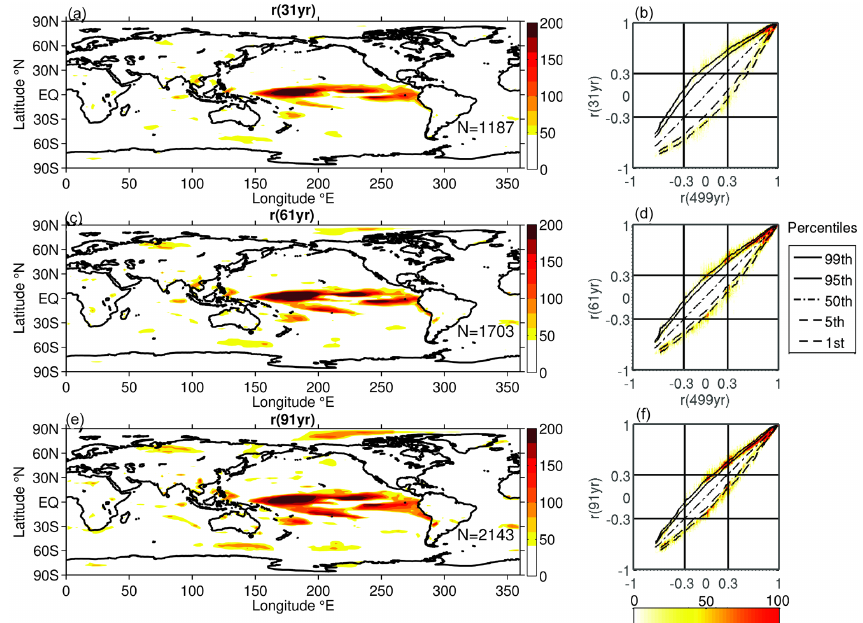
Figure 2. Panels (a) , (c) and (e) show the number of non-stationary windows (coloured shading) for each grid point over the entire data set for 31-, 61- and 91-year windows, respectively. This shading has been adjusted for the slightly different lengths of data available for the different calibration window length. The number of non-stationary grid points (using 499 years of data) for any window is shown in the bottom right corner of each panel as N . Panels (b) , (d) and (f) show the percentiles of correlations between global TS and Niño 3.4 in 31-, 61- and 91-year windows respectively ( y axis) versus the corresponding correlations for the whole 499 years of data ( x axis). This plot is very similar to Fig. 1a, but with the underlying coloured shading representing the y axis positions of non-stationary windows in the plot (according to definition of non-stationarity; see Sect. 3). A deeper red indicates a higher density of points, as many points can occupy the same correlation